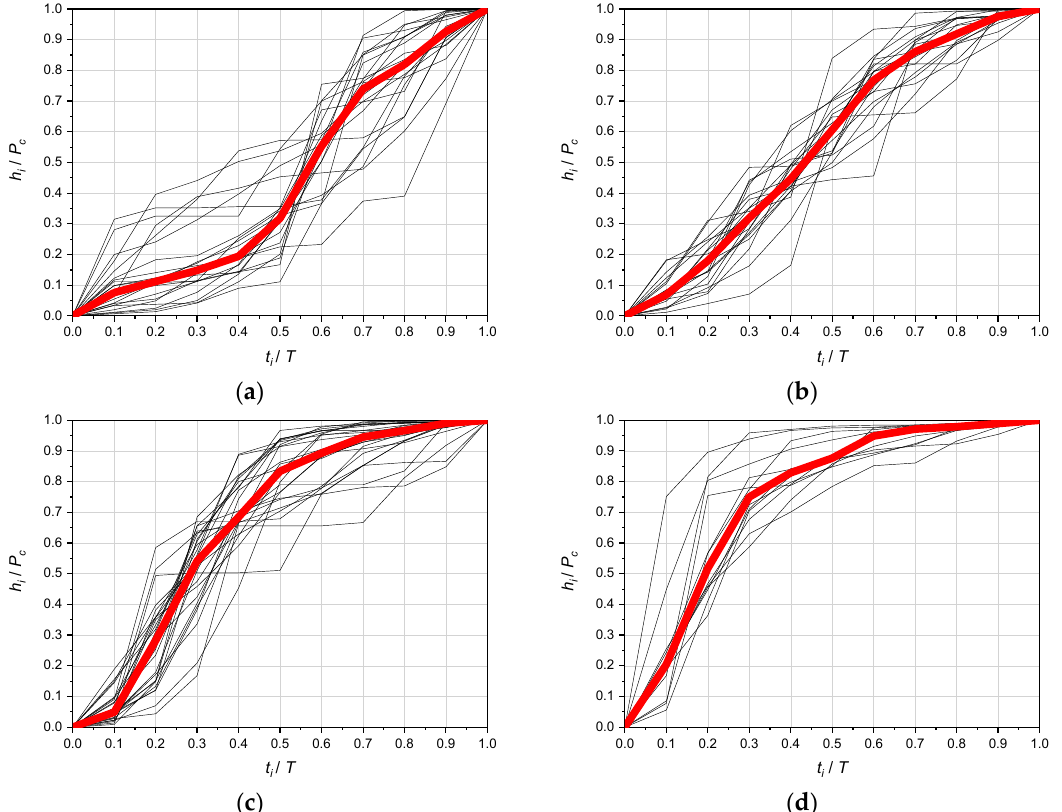
Figure 7. Dimensionless precipitation mass curves with a median for four clusters according to the Ward method: ( a ) Cluster No. 1, ( b ) cluster No. 2, ( c ) cluster No. 3, and ( d ) cluster No. 4.